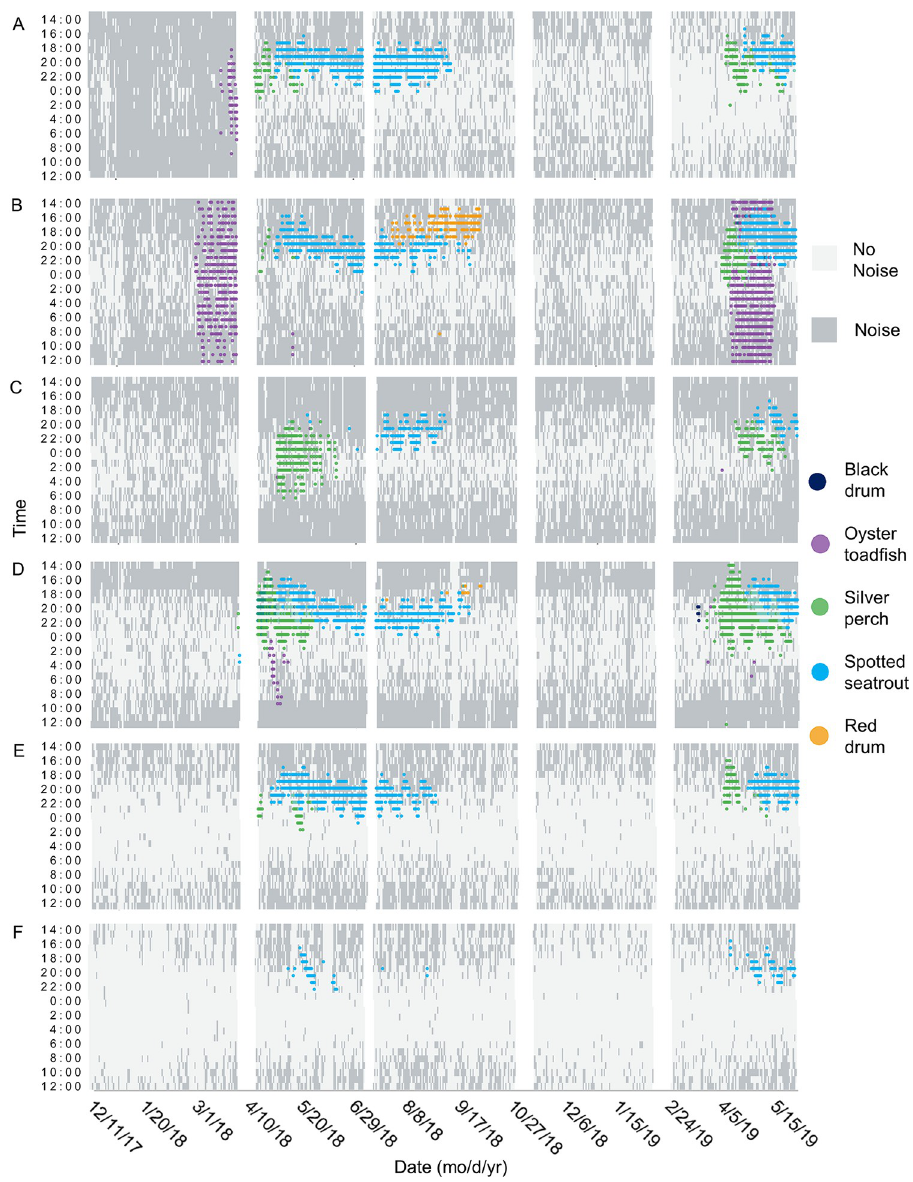
Fig 9. Heat map of fish chorusing with noise presence/absence background. Spatial and temporal patterns of fish chorusing in Charleston Harbor. Time is shown between noon and noon the next day at (A) Wando River, (B) Drum Island, (C) SC Aquarium, (D) Fort Sumter, (E) Ashley River, and (F) Citadel stations. Background color represents whether anthropogenic noise was present or absent. White spaces represent gaps in the data due to maintenance of equipment between deployments. Blended colors indicate an overlap in species